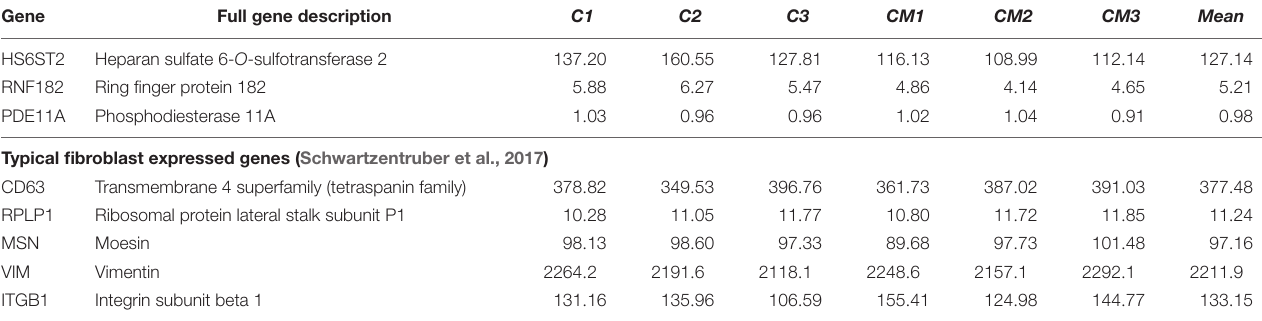
Frontiers in Molecular Neuroscience |